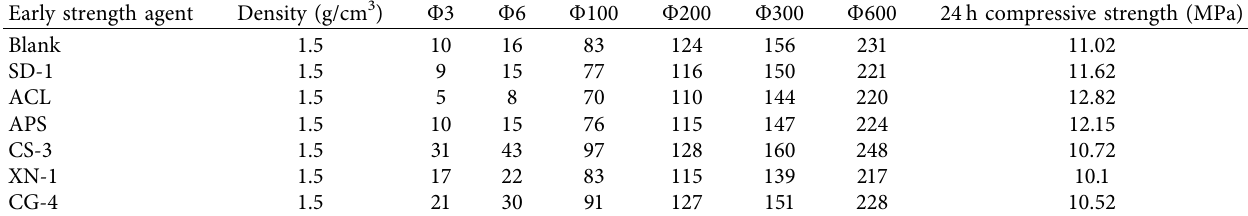
Table 8: Effect of different early strength agents.